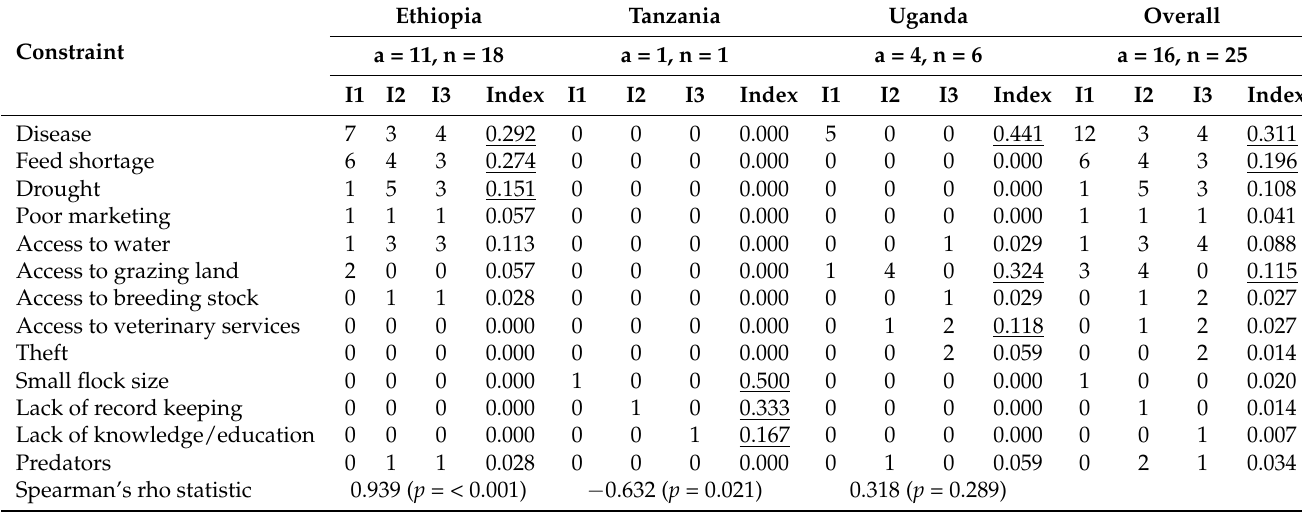
Table 1. Farmer-reported ranking of constraints to small ruminant